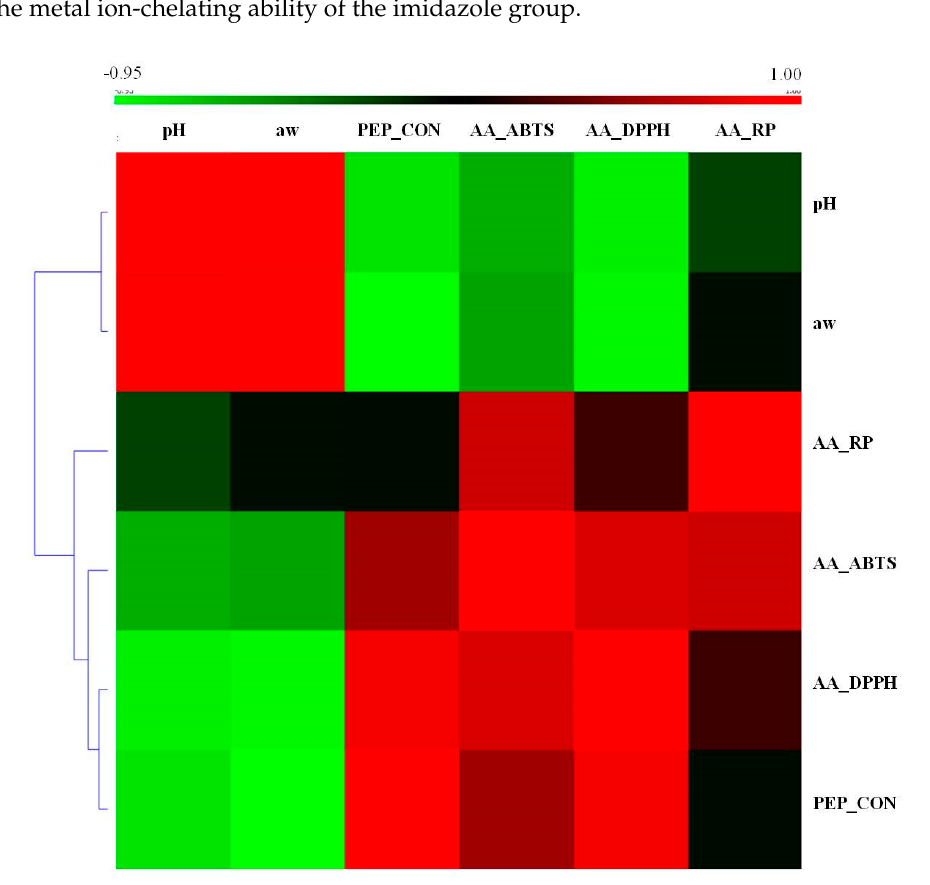
Figure 1. The correlations (shown as heat map) between research parameters.